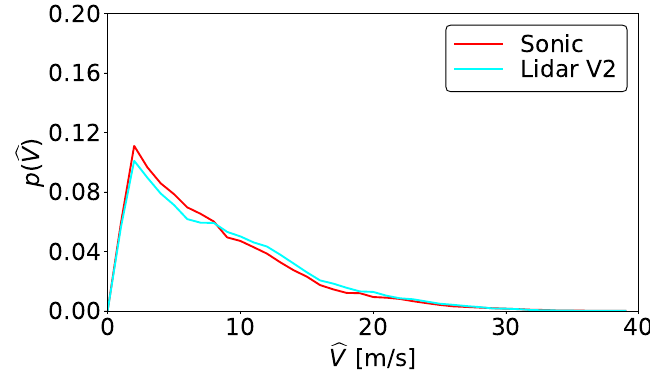
Figure 12. Probability density function (PDF) of the maximum wind speed in every 10-min time slot at 57 m height. Bin size for PDF is 1 m/s of peak wind sped.